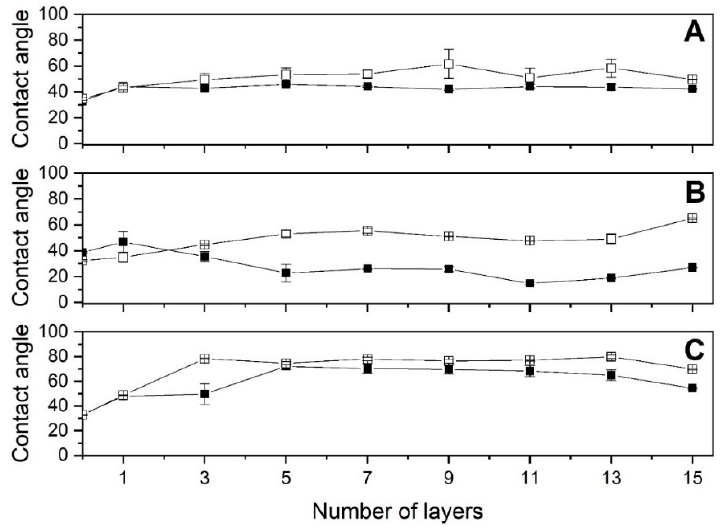
Figure 2. Water contact angle of PEMs with positively charged topmost layer composed of C1H ( A ), C2H ( B ) and CAm ( C ) alternately deposited with AH (black squares) or AAm (white squares).